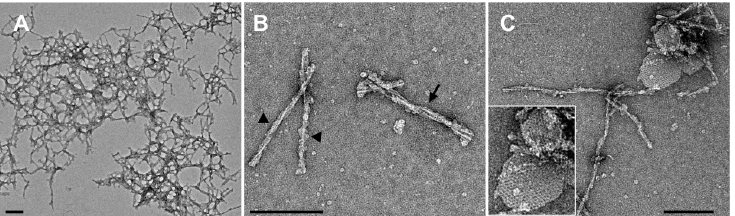
Fig 2. Negative stain electron micrographs of purified L-type BSE samples showing heterogeneous morphologies. Representative electron micrographs of ( A ) large PrP 27–30 aggregates, ( B ) isolated forms of both single (arrowheads) and double (arrow) protofilament fibrils, and ( C ) 2D crystals along with amyloid fibrils. Grids stained with 2% uranyl acetate. Scale bar = 100